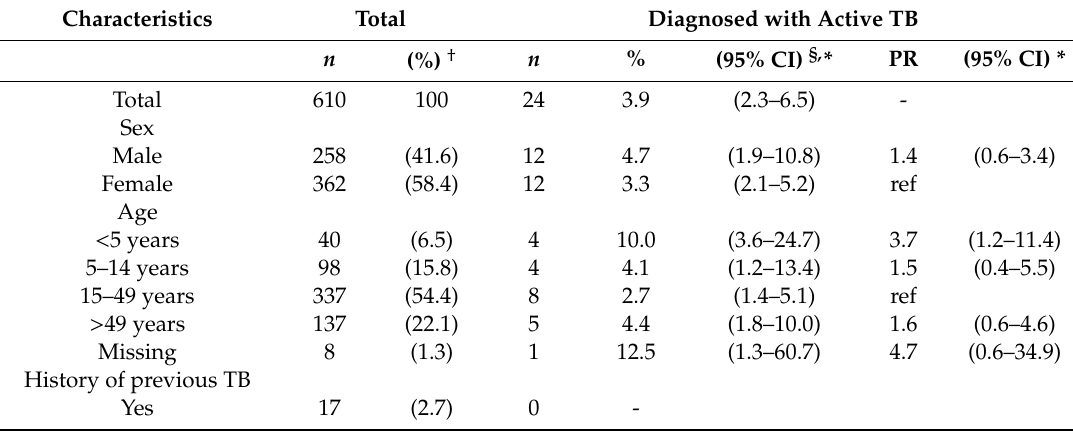
Table 2. Demographic and clinical characteristics of household contacts of MDR-TB patients